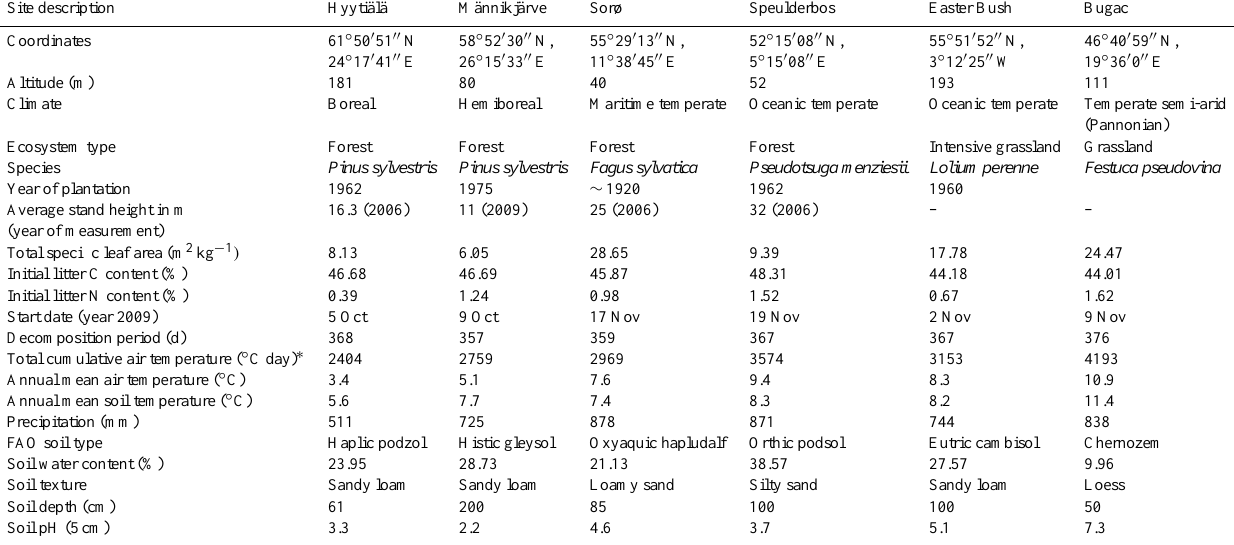
Table 1. Characteristics of the forest and grassland study sites. Site